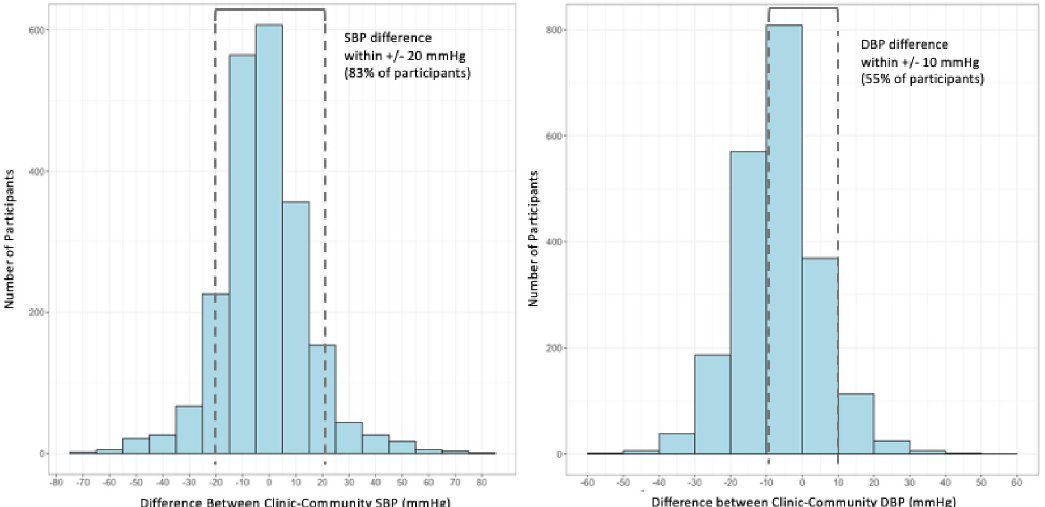
Fig 2. Difference in systolic and diastolic blood pressure between a participant’s clinic and community measurements (N = 2123).